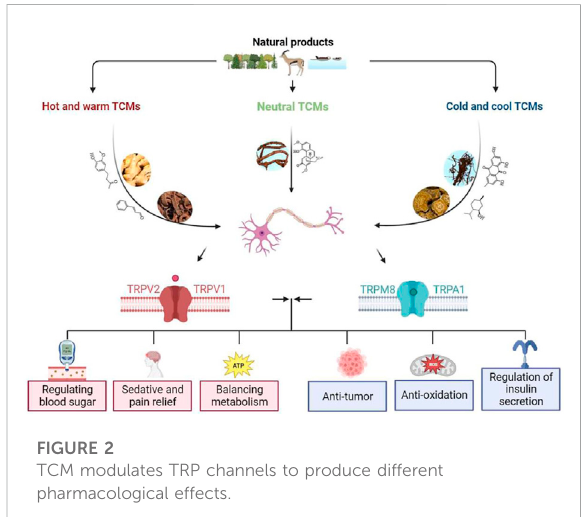
FIGURE 2 TCM modulates TRP channels to produce different pharmacological